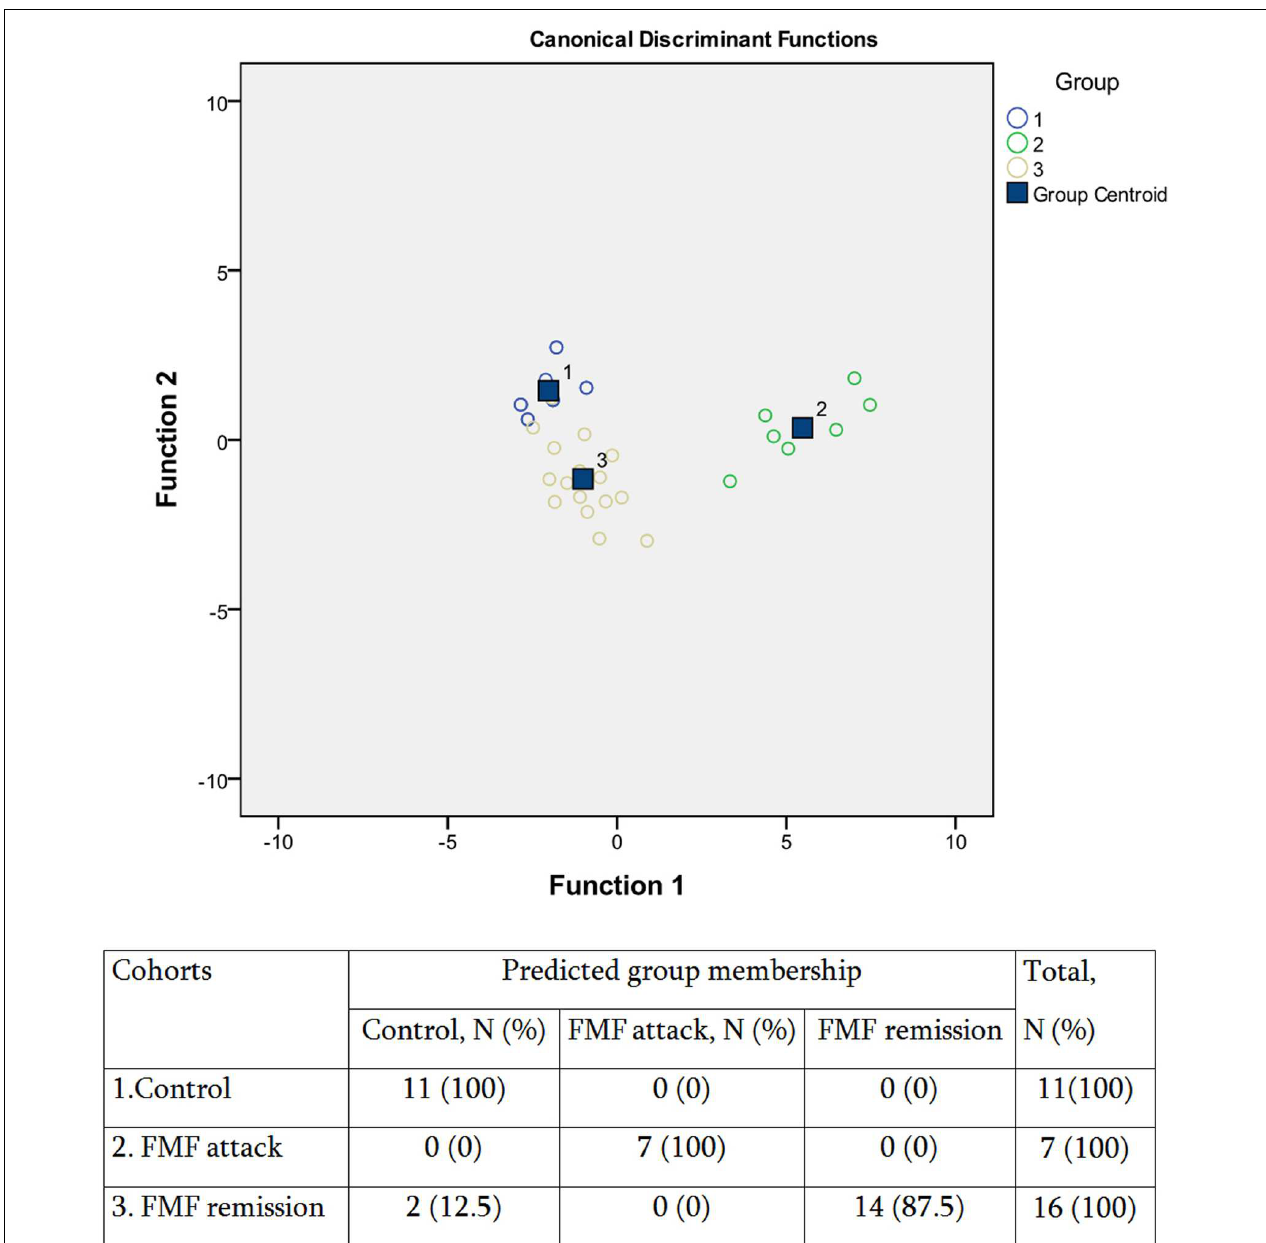
FIGURE 4 | Scatterplot of DA model and the predicted group membership in the model based on systemic concentration of microbial SCFAs in FMF patients (attack and remission) and in control subjects. Number of variables in the model – 8 and grouping consists of three cohorts. Root 1, 2 – discriminant functions 1 and 2 (1st and 2nd canonical roots). Groups: (1) control, (2) FMF attack, and (3) FMF remission. 0.94.1% of the original group cases were correctly classified; Wilks’s λ =